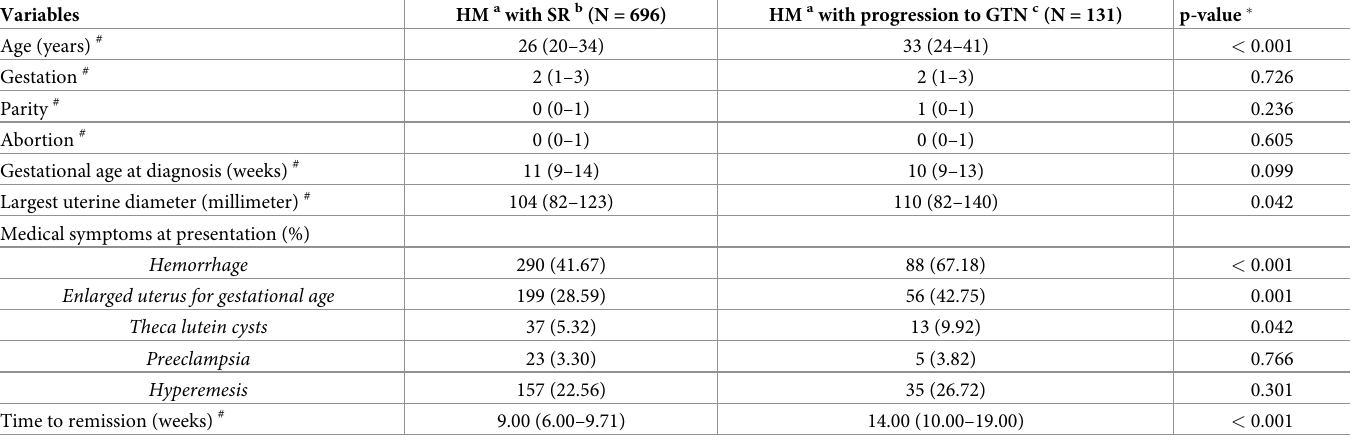
Table 1. Clinical characteristics of patients with complete hydatidiform mole associated with spontaneous remission or progression to gestational trophoblastic